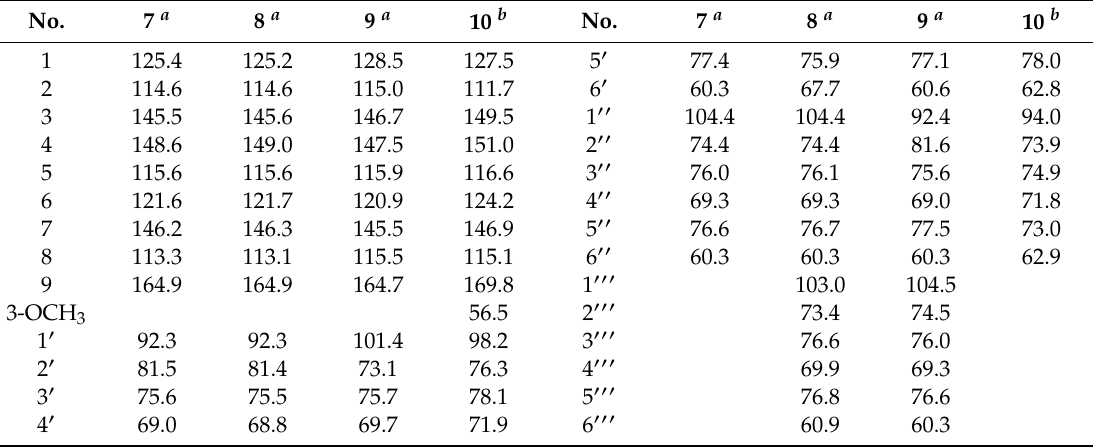
Table 2. 13 C-NMR data for 7 – 10